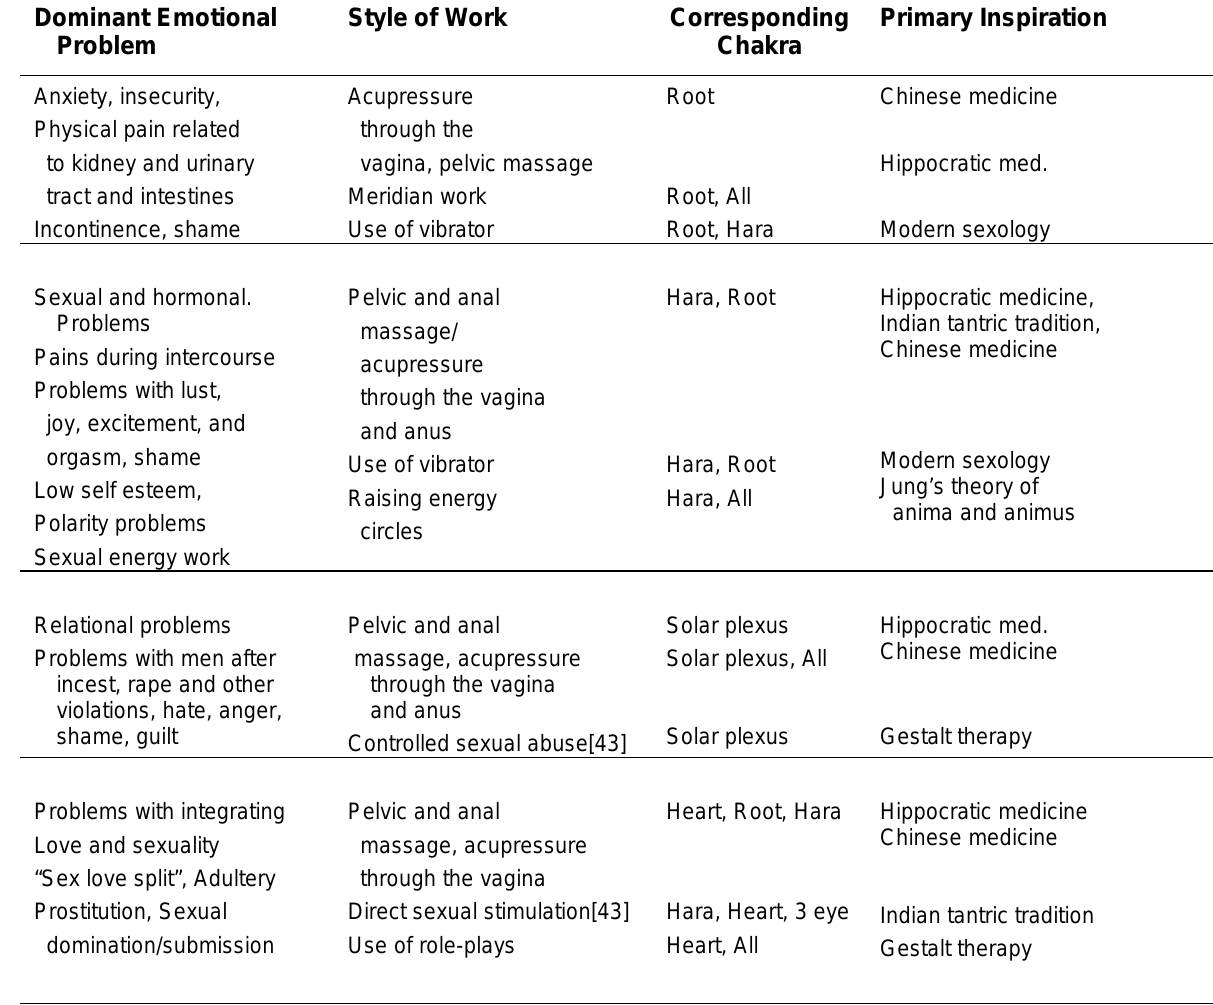
Different Forms of Traditional Pelvic Massage/Acupressure Through the Vagina Organized According to the Emotional Core